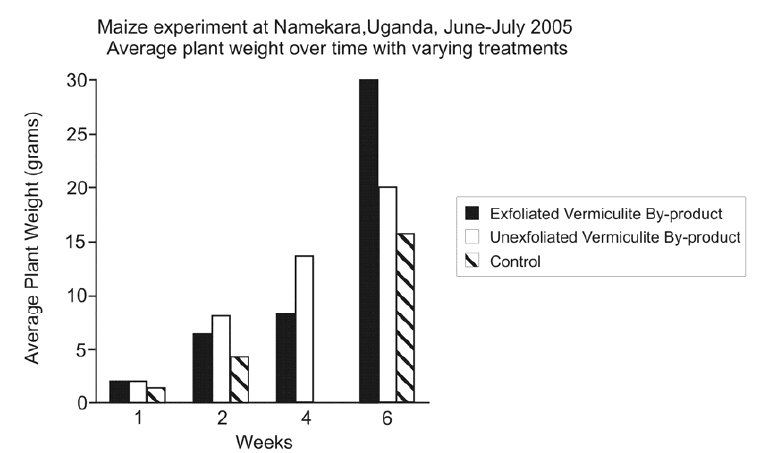
Fig. 1 – Effects of vermiculite by-product on total maize weight (roots and shoots), averaged over three plants, over a six-week period. No control sample was taken in week 4. Test pots = 26L red soils, application rates 180 cc of exfoliated and unexfoliated Namekara vermiculite by-product